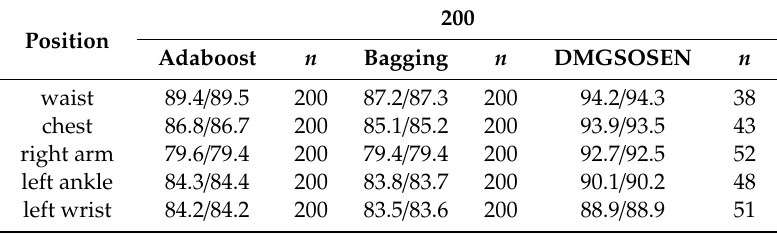
Table 14. Performance comparison with Adaboost and Bagging on 200 ELMs (Accuracy / F1%).